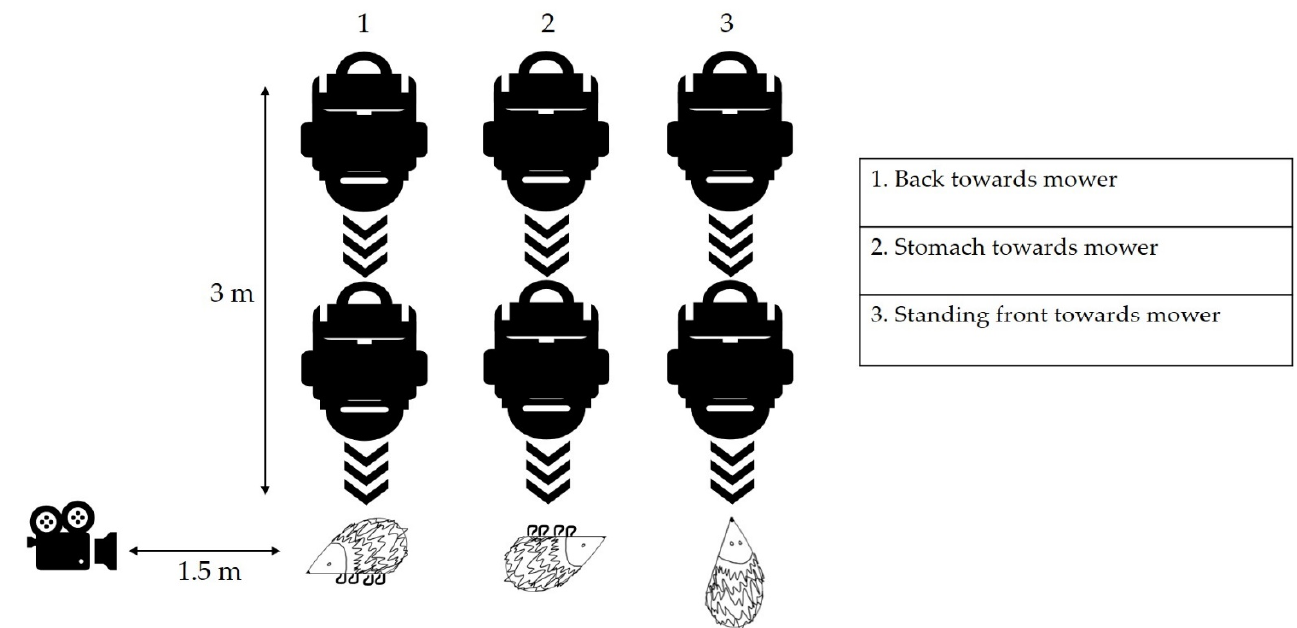
Figure 2. An overview of the test setup. Each robotic lawn mower was tested 12 times in total, 3 times per dead hedgehog representing 1 of 4 weight classes. A hedgehog from each of the four weight classes was placed in three different positions. The three positions were ( 1 ) Lying on the side with the back oriented towards the approaching robotic lawn mower; ( 2 ) Lying on the side with the stomach oriented towards the approaching robotic lawn mower; ( 3 ) Standing upright on its feet with the head oriented towards the approaching robotic lawn mower. The damage recorded from each test was categorised as 0-A according to the damage categories.